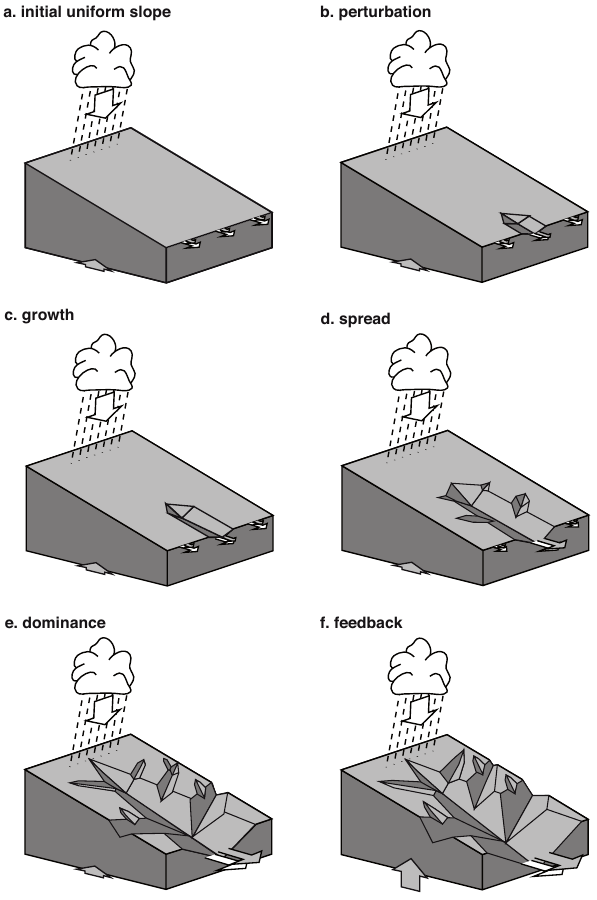
Fig. 7. Six stages of structure formation that reflect increasing lev- els of disequilibrium and ability to generate free energy and drive sediment transport. See main text for